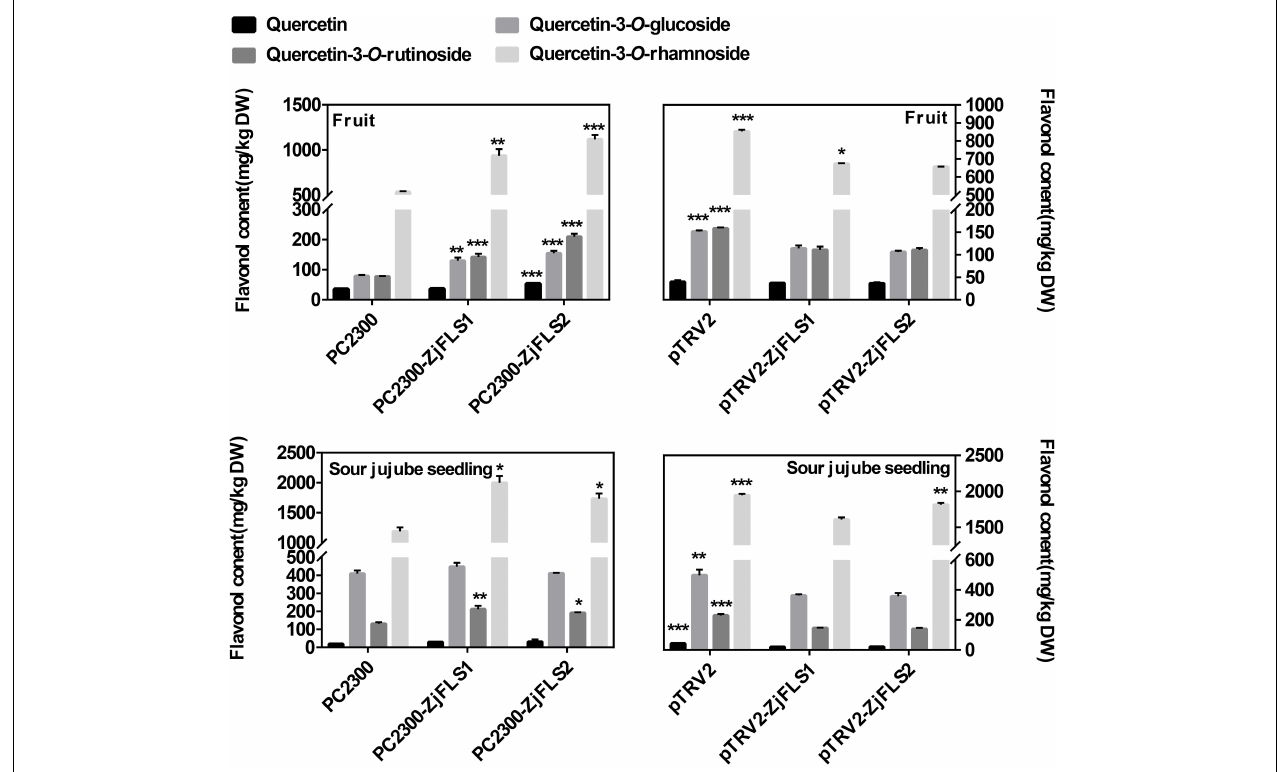
FIGURE 6 | Flavonol contents of jujube fruit and sour jujube seeds 10 days after infiltration. Error bars show the means ( n = 3). Data were analyzed with Student’s t -test (* P < 0.05, ** P < 0.01, *** P < 0.001).